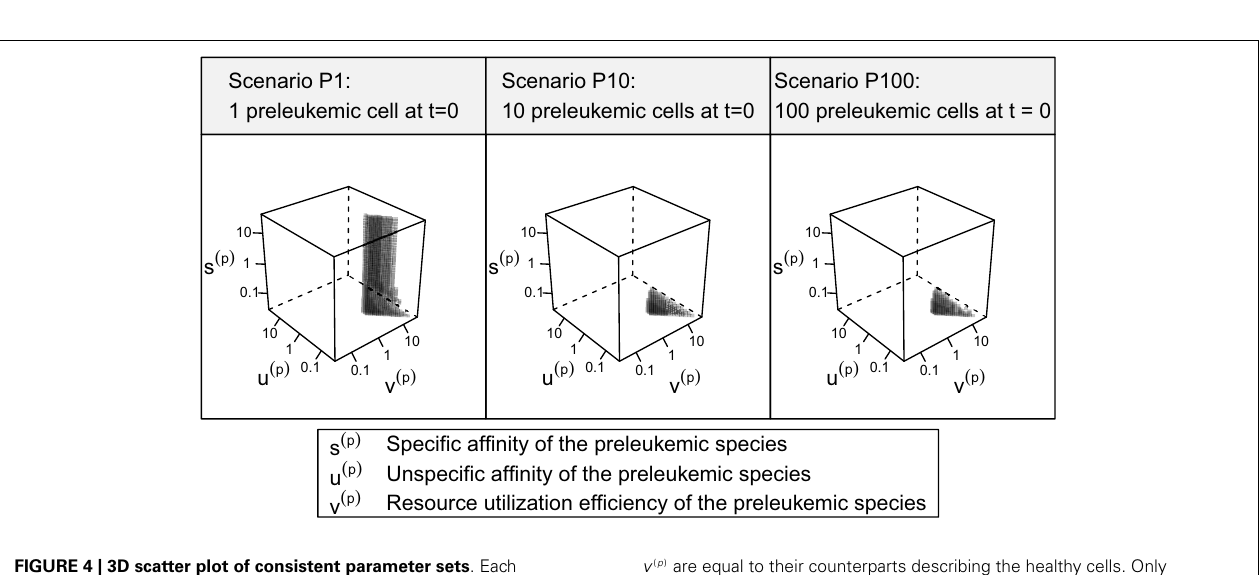
FIGURE 4 | 3D scatter plot of consistent parameter sets . Each tested parameter set can be represented by a point in one of the three presented cubes, the coordinates representing the fold-changes of s ( p ) , t ( p ) , and v ( p ) in comparison with their healthy counterparts s ( h ) , u ( h ) , and v ( h ) . In the center of each cube, the parameters s ( p ) , u ( p ) , and